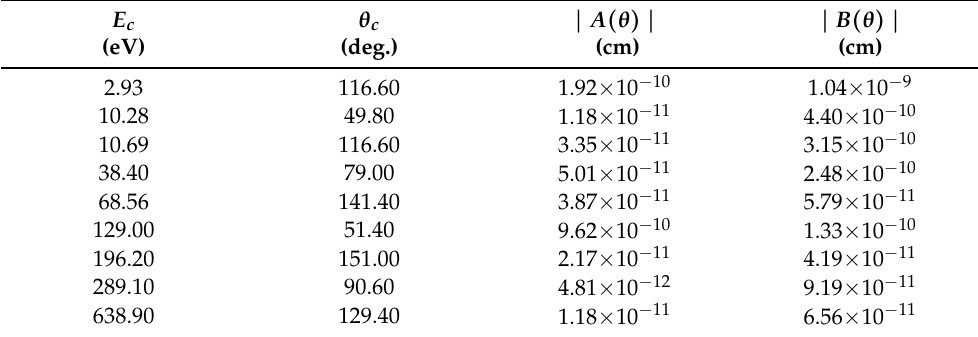
Table 5. The energy and angular positions and the values of direct and spin-flip scattering amplitudes of the deep minima (DM) in the DCS for elastic e − − Pd scattering.